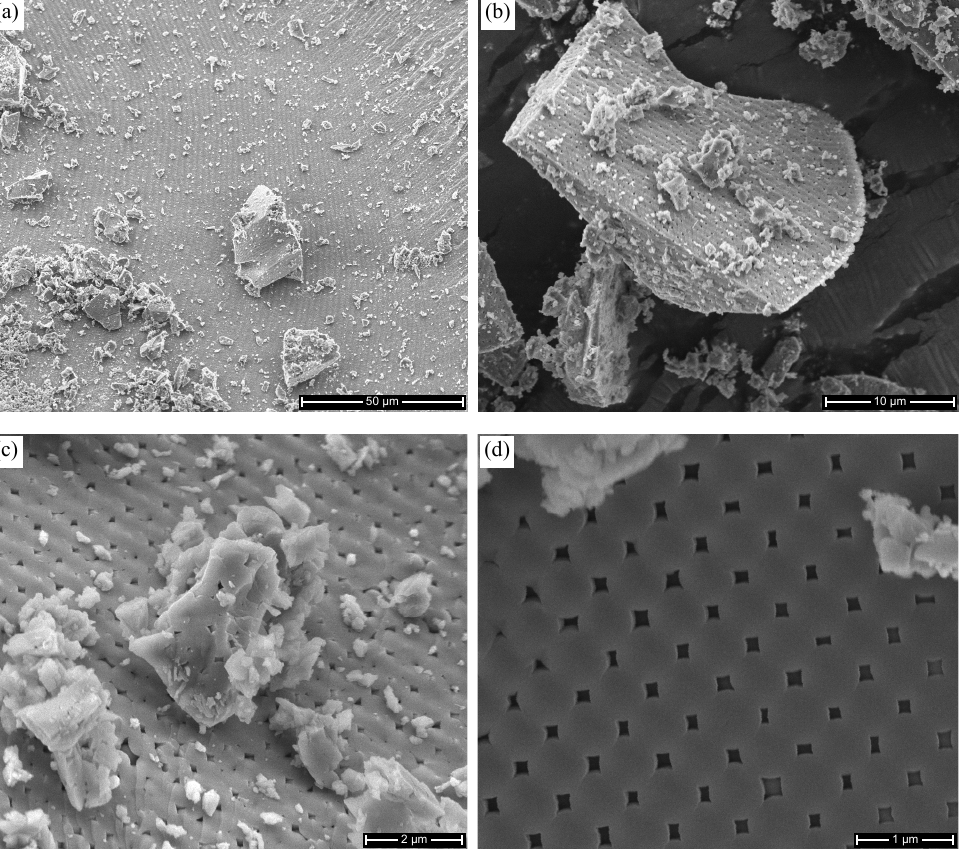
Figure 2. SEM images showing the effect of grinding on a sample of opal-AG (G9812 from Coober Pedy South Australia, Australia) ( a ) lightly crushed and ( b – d ) finest grinding with increasing magnification.